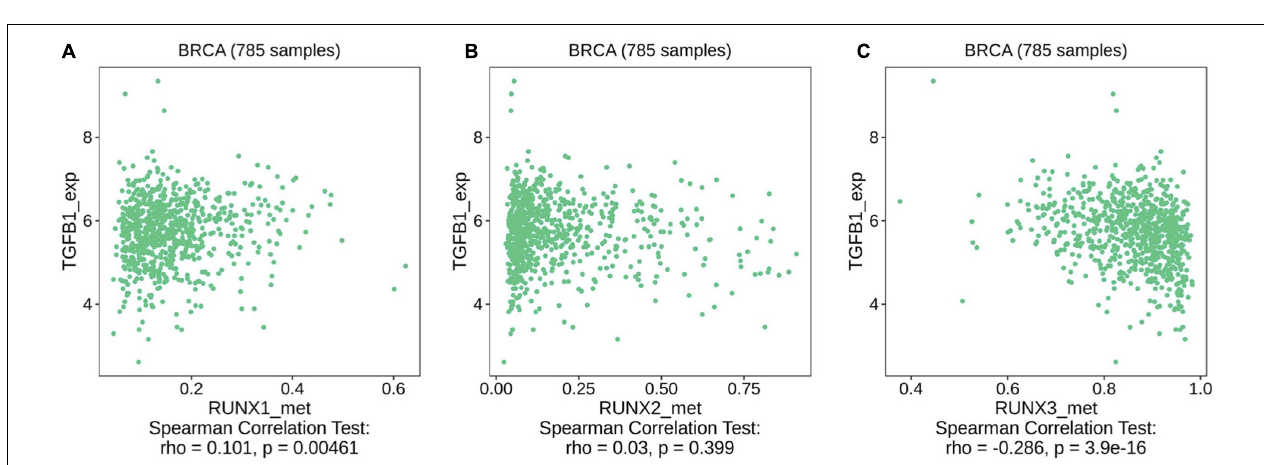
FIGURE 12 | Correlation between RUNX methylation level and immune cell infiltration in breast cancer. The correlations between changes in the methylation levels of (A) RUNX1, (B) RUNX2, and (C) RUNX3 with the infiltration of B cells, CD8 + T cells, CD4 + T cells, macrophages, neutrophils, and dendritic cells in breast cancer were shown.